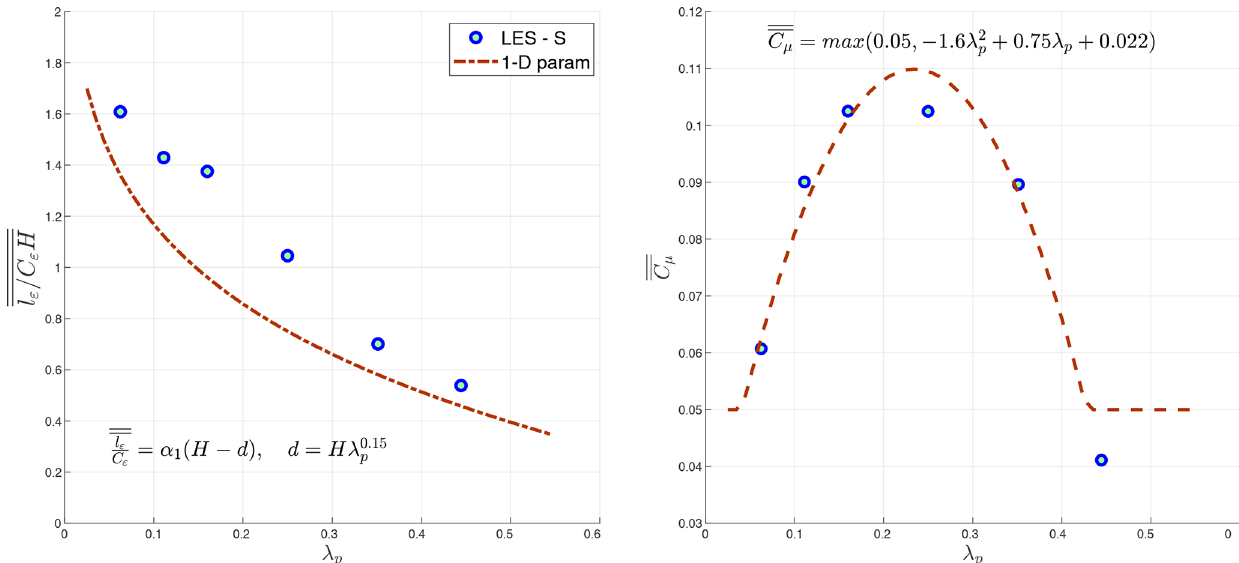
Figure 11. Variation in normalized dissipation length scale ( l ε /C ε H ) and model constant for turbulent viscosity ( C µ ) averaged within the canopy ( z/H < = 1) with plan area density ( λ p ). The results are obtained using the staggered urban configuration (Fig. 3) and averaged in the canopy volume ( Q indicates volume average of quantity Q